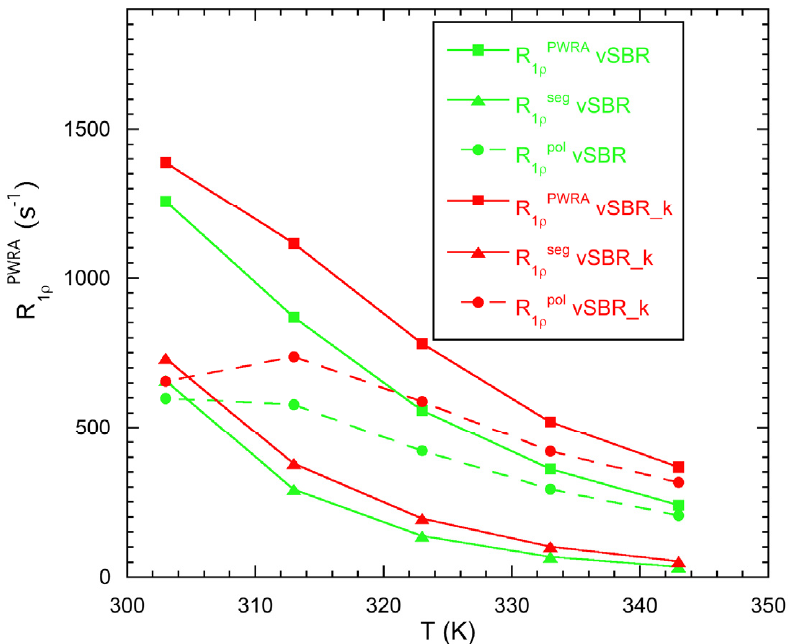
Figure 5. 1 H R 1 ρ PWRA (experimental), R 1 ρ seg (calculated) and R 1 ρ pol (calculated) vs. temperature for the indicated samples. The lines are plotted to guide the eye.